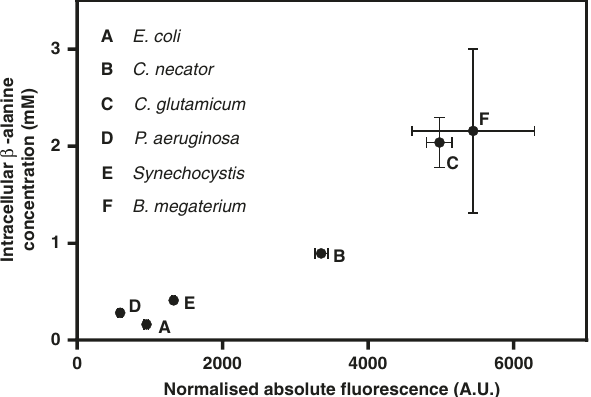
Fig. 8 Correlation between biosensor output and intracellular β -alanine concentration. Absolute normalised fl uorescence values of C. necator cells, carrying plasmids containing the β -alanine biosensor and each a gene encoding a different homologue of L-aspartate 1-decarboxylase enzyme, correlated with their corresponding intracellular β -alanine concentration quanti fi ed by HPLC-UV. Cells were grown in MM. Samples were taken 6 h after supplementation with L-aspartate and L-arabinose. Data are mean ± SD, n = 3. Source data are provided as a Source Data fi